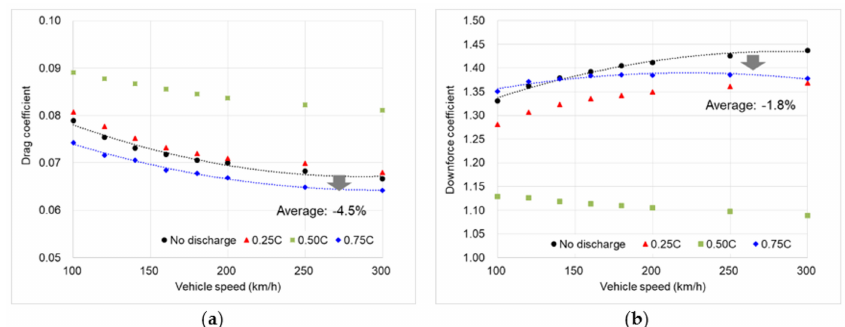
Figure 7. Comparison of aerodynamic coe ffi cients for various discharge positions at Vb / U = 0.4 ( a ) Aerodynamic drag coe ffi cient; ( b ) Downforce coe ffi cient.